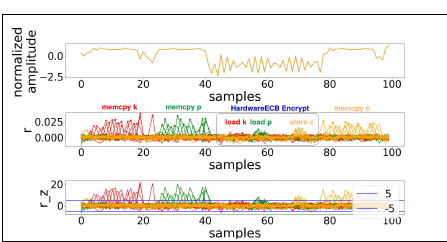
Figure 16: ρ -test on hardware AES-128 , using 350000 · 100 traces at 10 cm, in an office environment. Peaks for HW [ k ] (red), HP [ p ] (green) and HW [ c ] (orange) are visible. The bigger peaks correspond to the firmware copying the values to the data structure known by the hardware block. The smaller peaks are due to the hardware block loading those